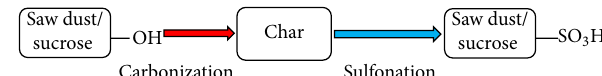
Figure 1: Schematic preparation of saw dust and sucrose acid catalysts. Carbonization process removes volatile compounds like phenols from sawdust producing char; sulfonation adds (–SO 3 H) group to the char forming carbonized + sulfonated saw dust or sucrose